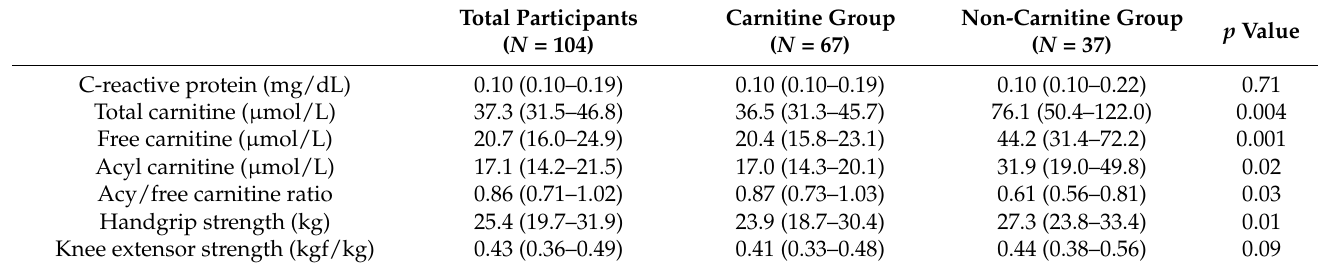
The table indicates numbers, percentages, or median (interquartile range) values. p values were by Mann–Whitney U test or χ 2 test.